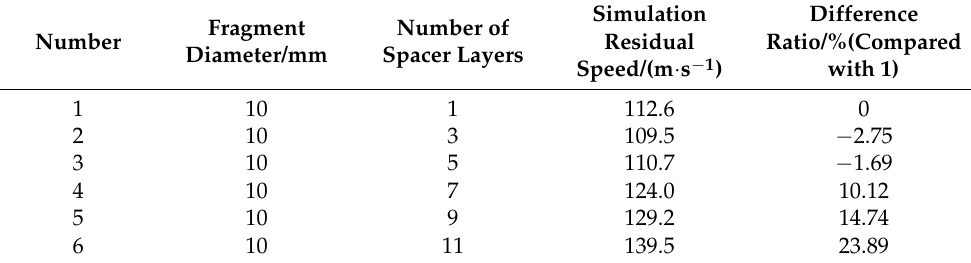
Table 6. Effect of the number of spacer layers on the residual